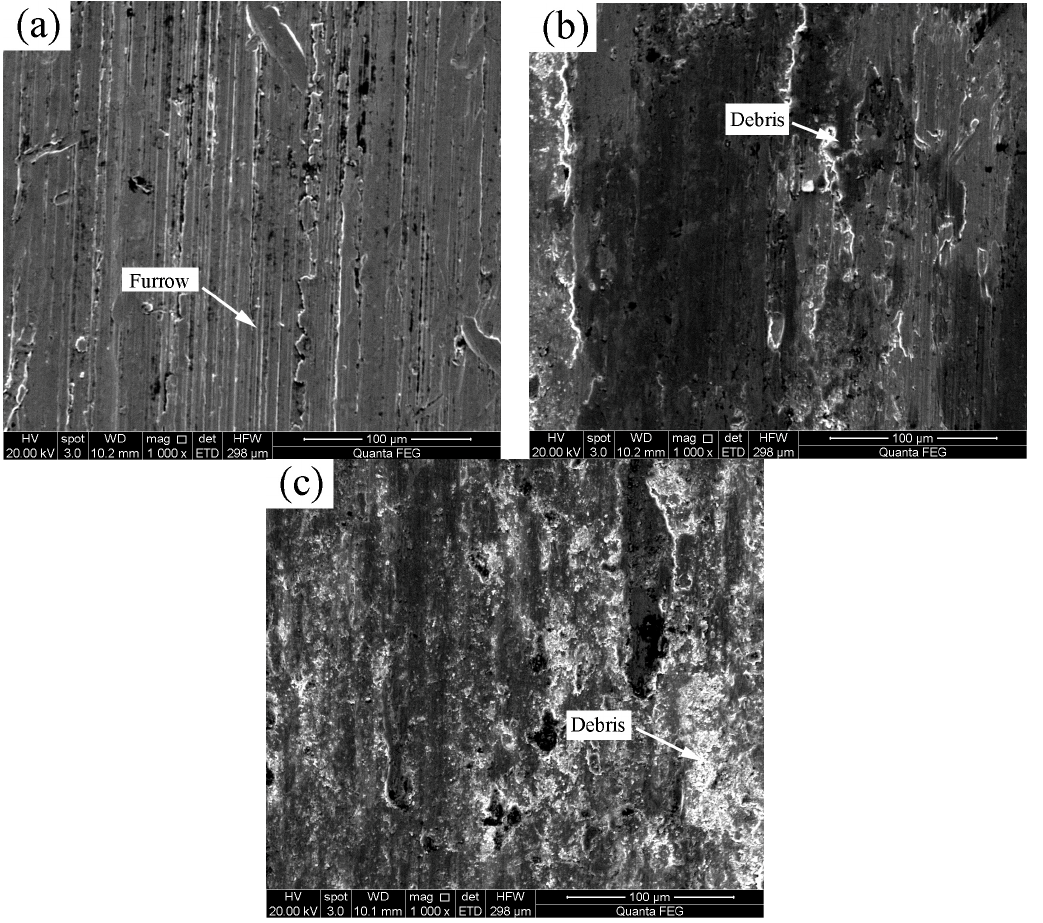
Figure 7. Morphologies of worn surfaces of Ni-based claddings with different Co contents: ( a ) NiCo00; ( b ) NiCo15; ( c ) NiCo30.